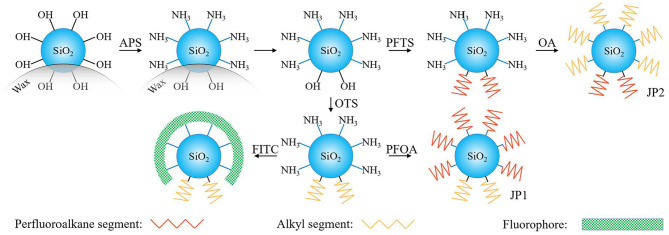
Scheme for the synthesis of two Janus particles from a Pickering emulsion. The exposed and non-exposed areas of silica particles on the wax droplets were inconsistent. No wax covered surface of silica particles is coated by APS and provides a reaction site for further grafting of fluorocarbon chains or hydrocarbon chains.